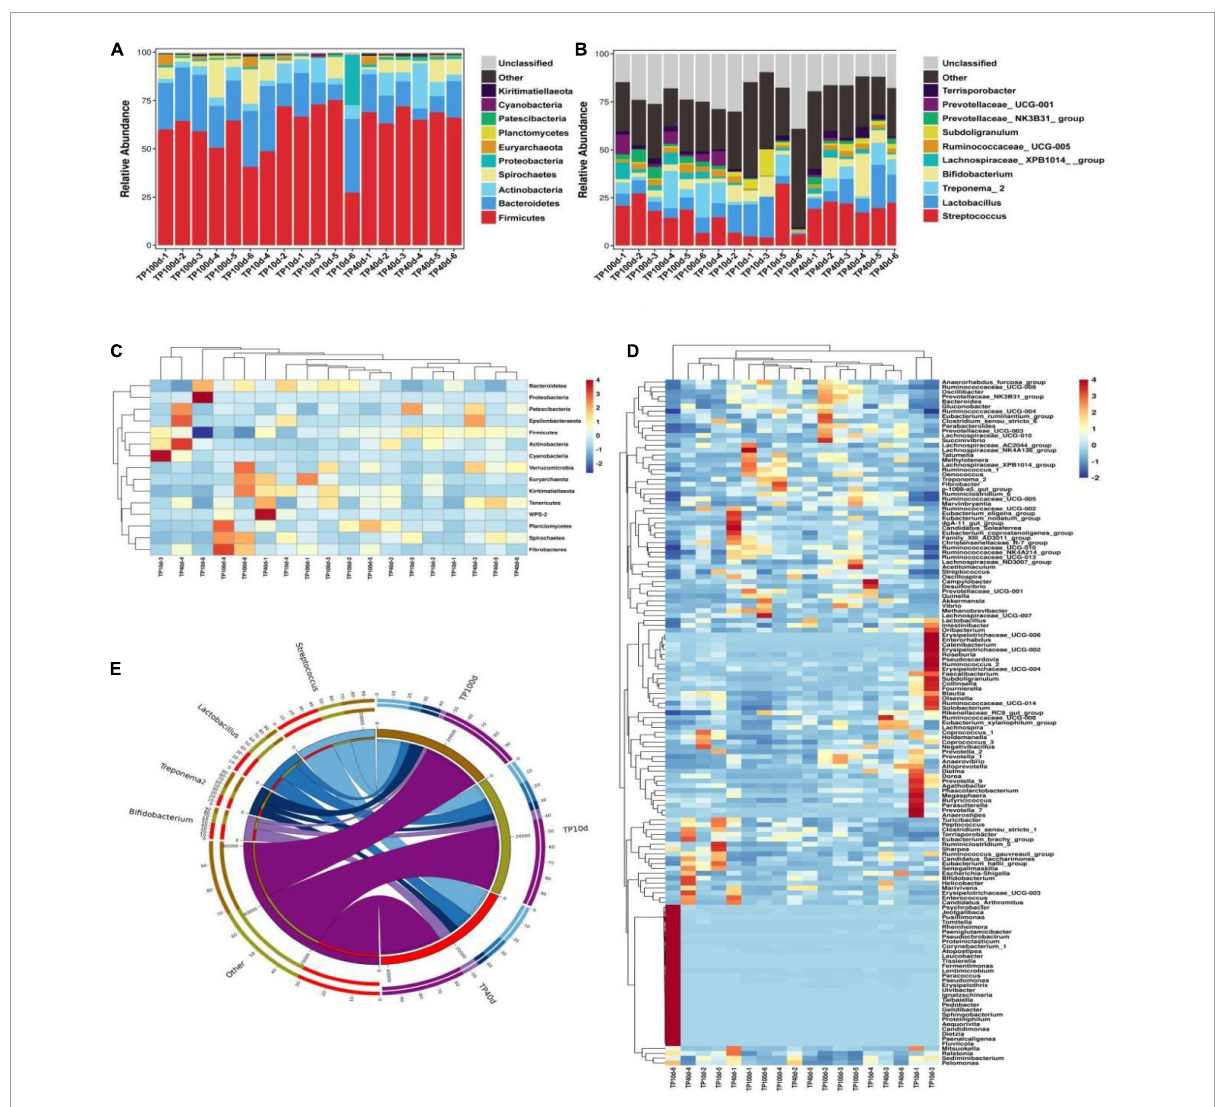
FIGURE1 Relative abundance and heat map of intestinal microflora in Tibetan pig at phylum and genus levels at different growth stages. (A,B) Represent the community distribution at the phylum and genus level, respectively. (C) Heat maps of the top 17 common gates in different communities. (D) Heat maps of the top 96 common genera in different communities. Each color block in the heat map represents the relative abundance of a genus in the sample. Clustering can distinguish taxons with different abundance, and color gradient and similarity is reflecting the similarities and differences of multiple samples at different classification levels. The blue-red gradient shows the change of abundance from low to high. (E) The composition of microorganisms among horizontal species.